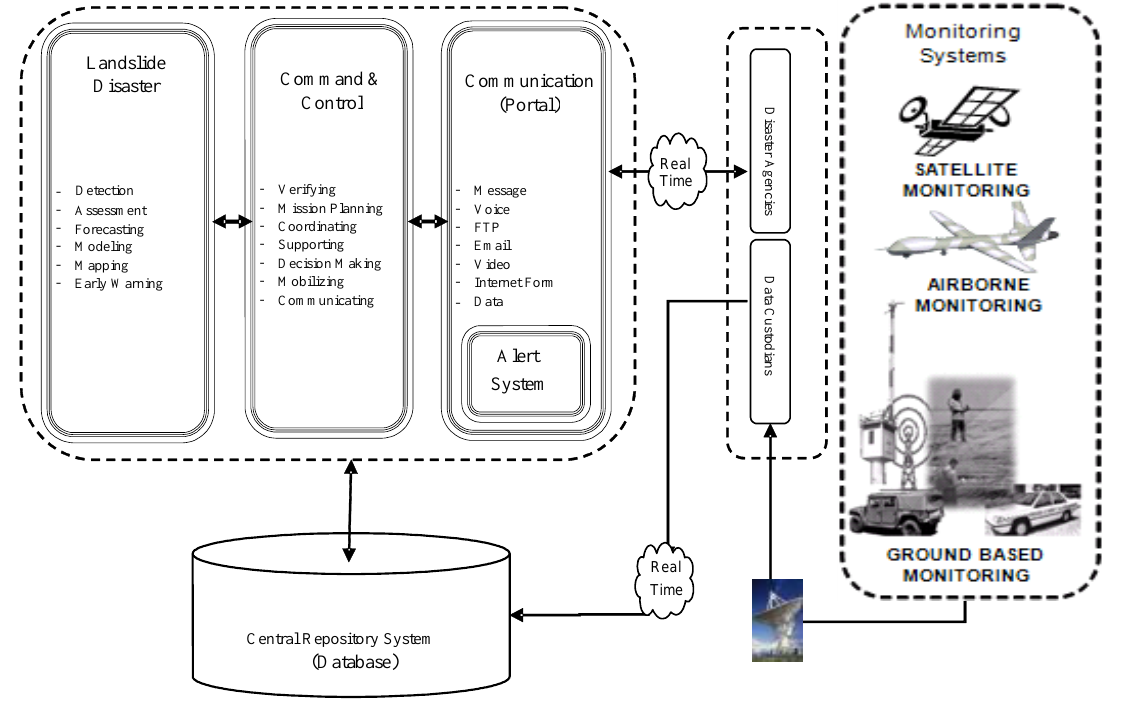
Figure 1. Schematic Design and Operational Framework of the Landslide Monitoring and Management System.